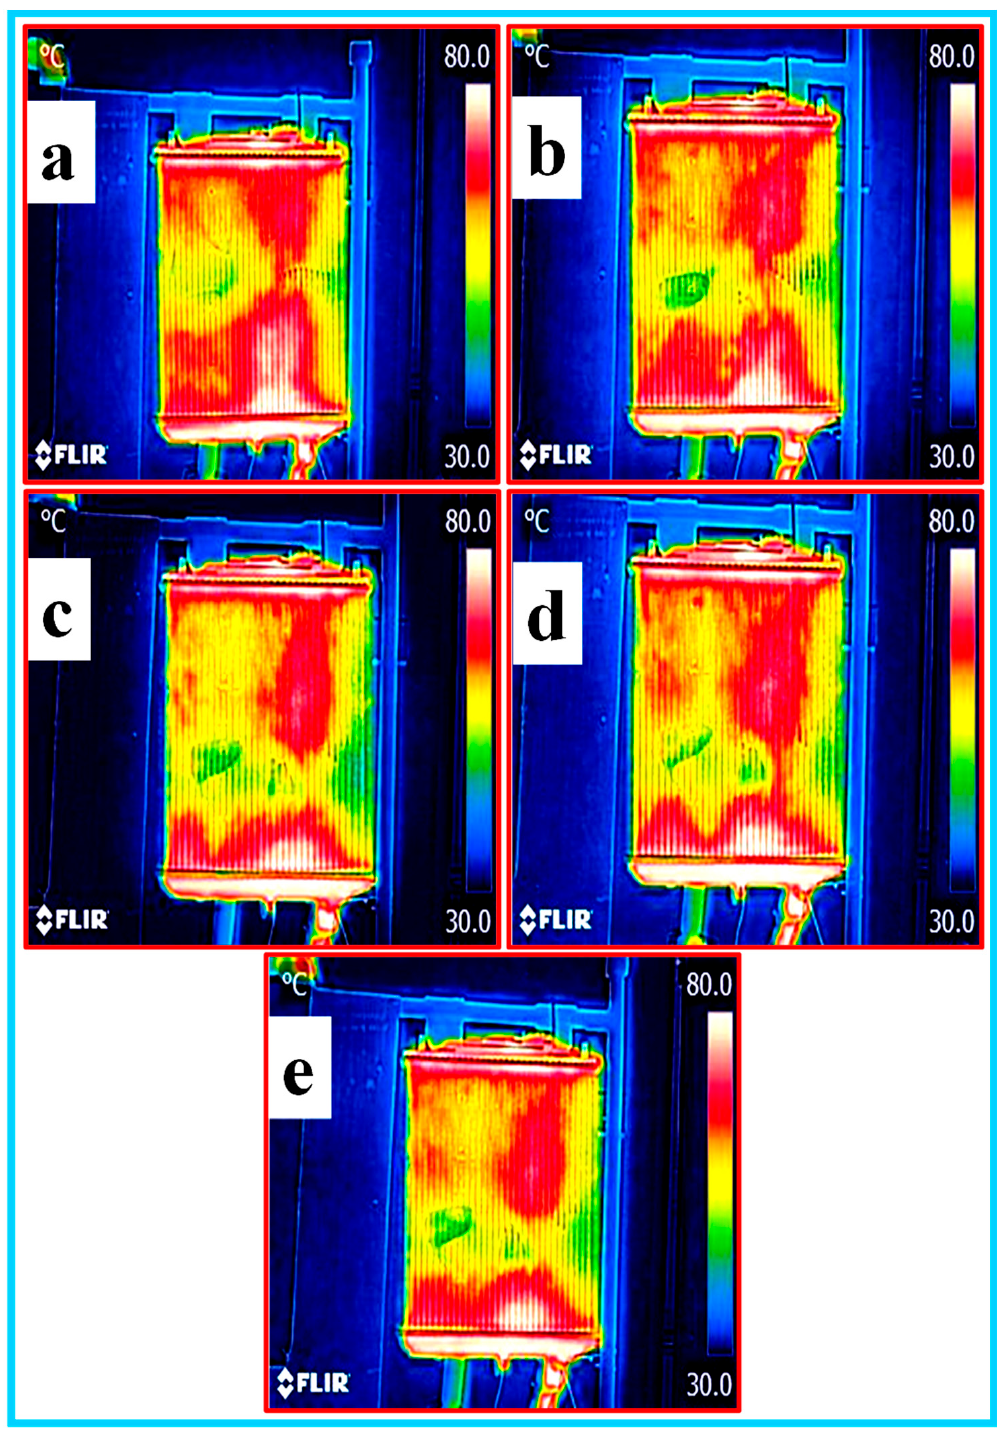
Figure 14. Thermal imaging of the Al 2 O 3 /CNC with a 0.5% volume concentration in the radiator ( a – e ).